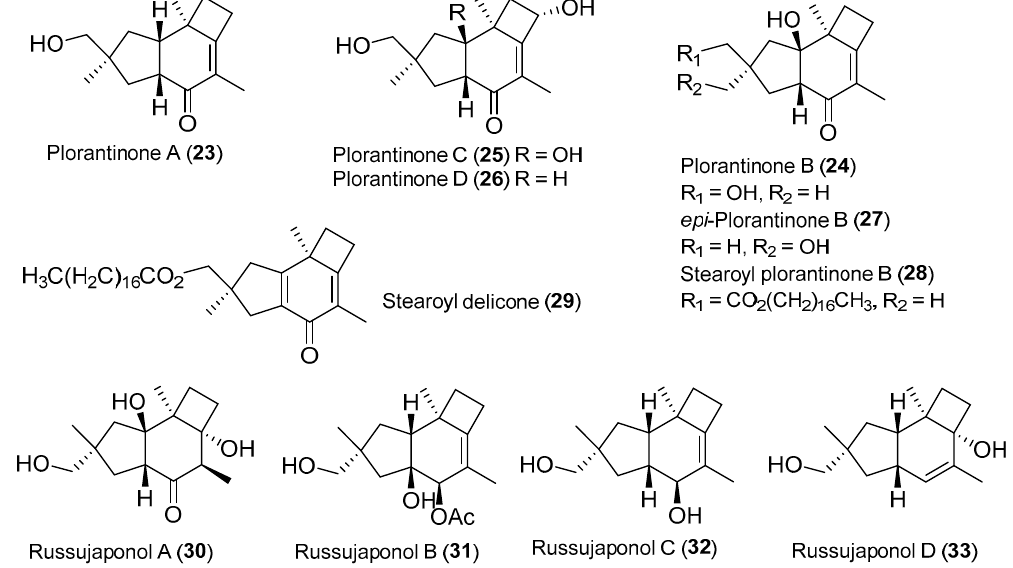
Figure 7. Structures of protoilludanes 23 – 33 isolated from the Russula genus of fungi.